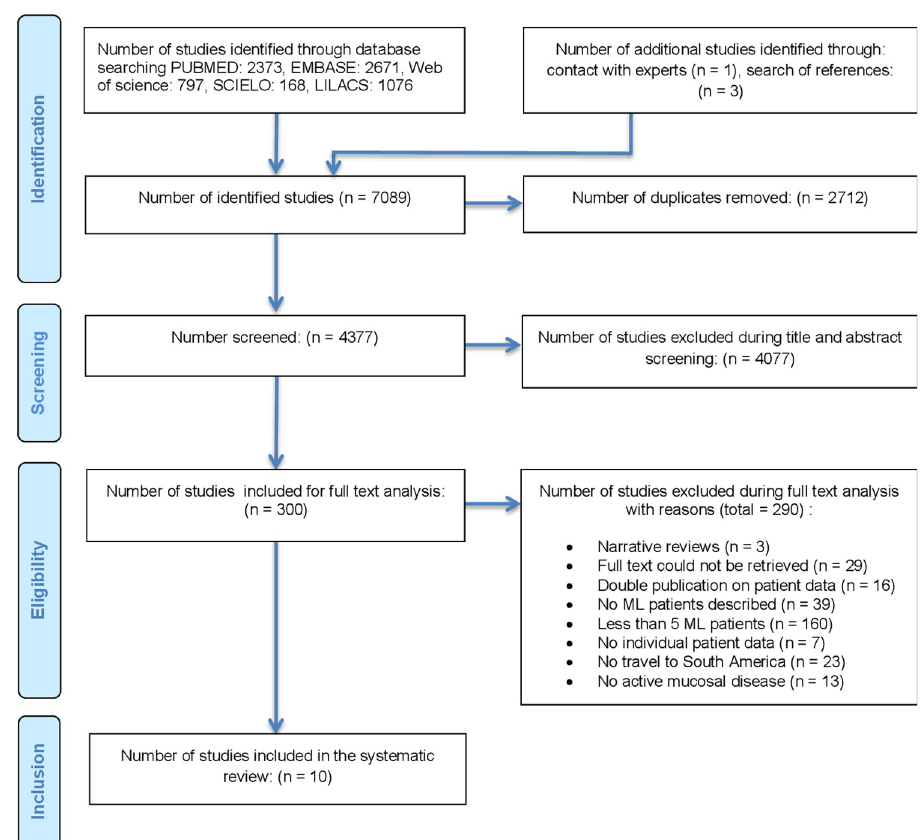
Fig 1. PRISMA literature assessment flow